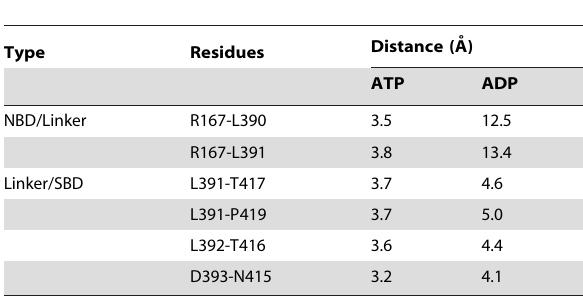
Table 1. List of the interdomain interactions and their corresponding average distances extracted from the contact map difference ATP/ADP (see text for